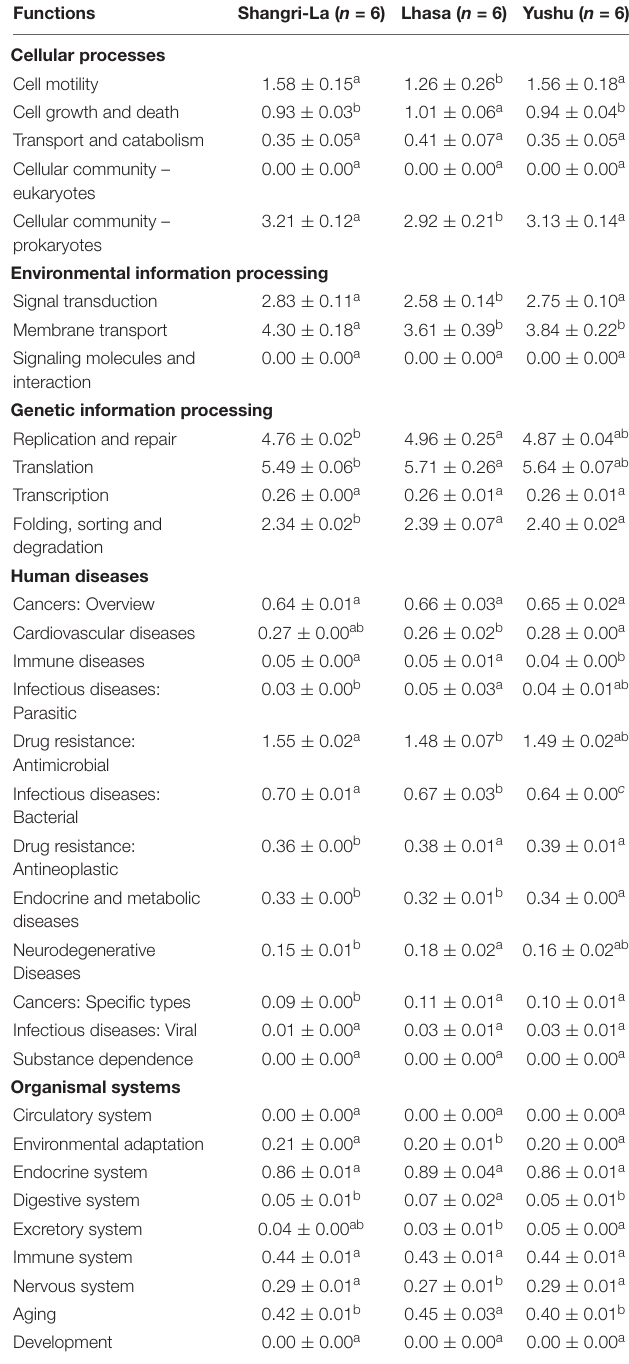
TABLE 1 | The predicted functional composition (%) of the microbiota of yaks from different regions. Functions